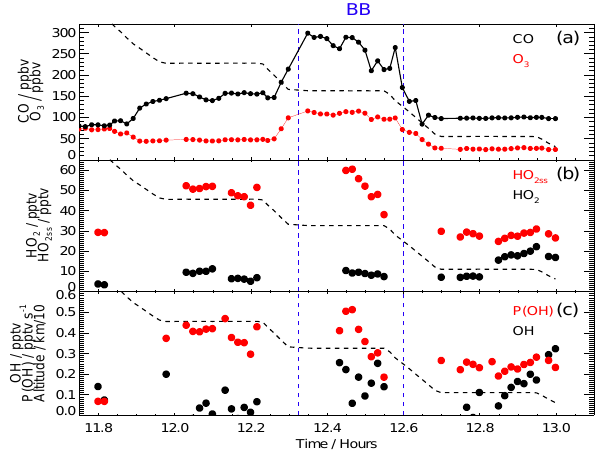
Fig. 19. Latitudinal variation of (a) OH and (b) HO 2 mixing ratio. Observations in the boundary layer are shown for data collected above the Sahel (13.75 ◦ –18 ◦ N, white), Forest (7.3 ◦ – 13.2 ◦ N, green), Ocean (4 ◦ –6 ◦ N, blue) and Urban areas (6 ◦ –7.3 ◦ N and 13.2 ◦ –13.75 ◦ N, red). Observations in the free troposphere in all regions are shown in black.